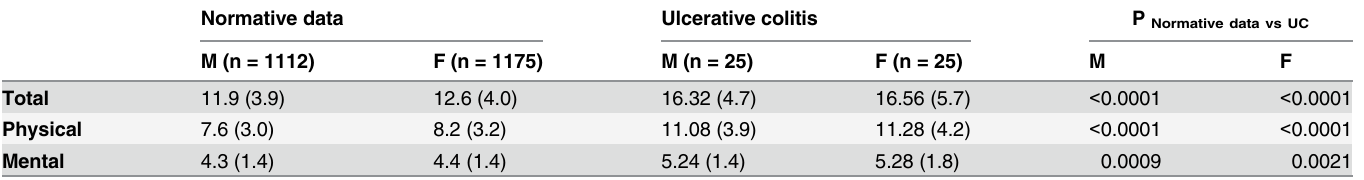
Table 3. Mean fatigue scale scores. Normative data in the Norwegian population compared to patients with UC on inclusion. Normative data